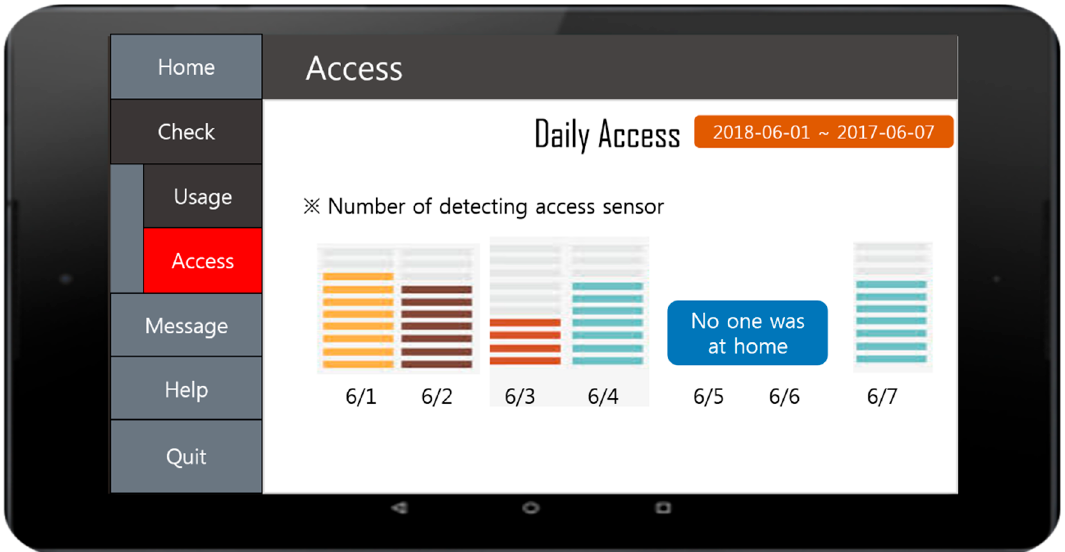
Figure 16. The Front Door Access Detection User Interface of the Proposed Android Application.